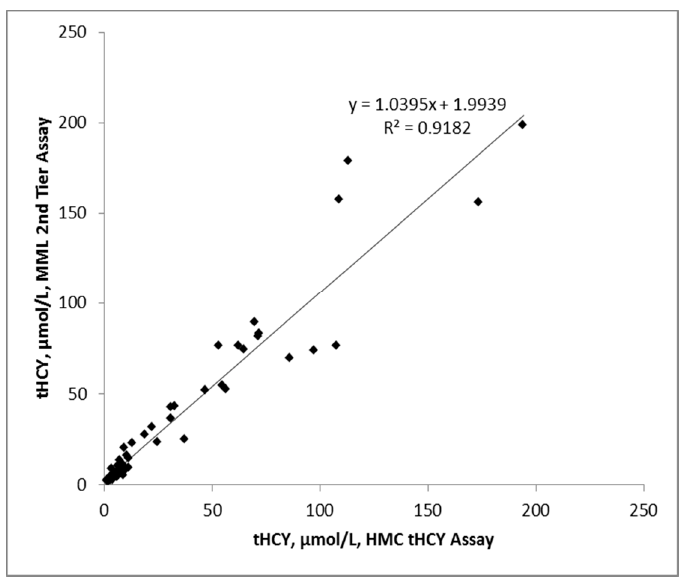
Figure 4. Comparison of tHCY results ( n = 63) obtained by the Hamad Medical Corporation (HMC) using the tHCY method described in this report and by Mayo Clinic’s Biochemical Genetics Laboratory using a previously published liquid chromatography tandem mass spectrometry (LC-MS/MS) method [18].